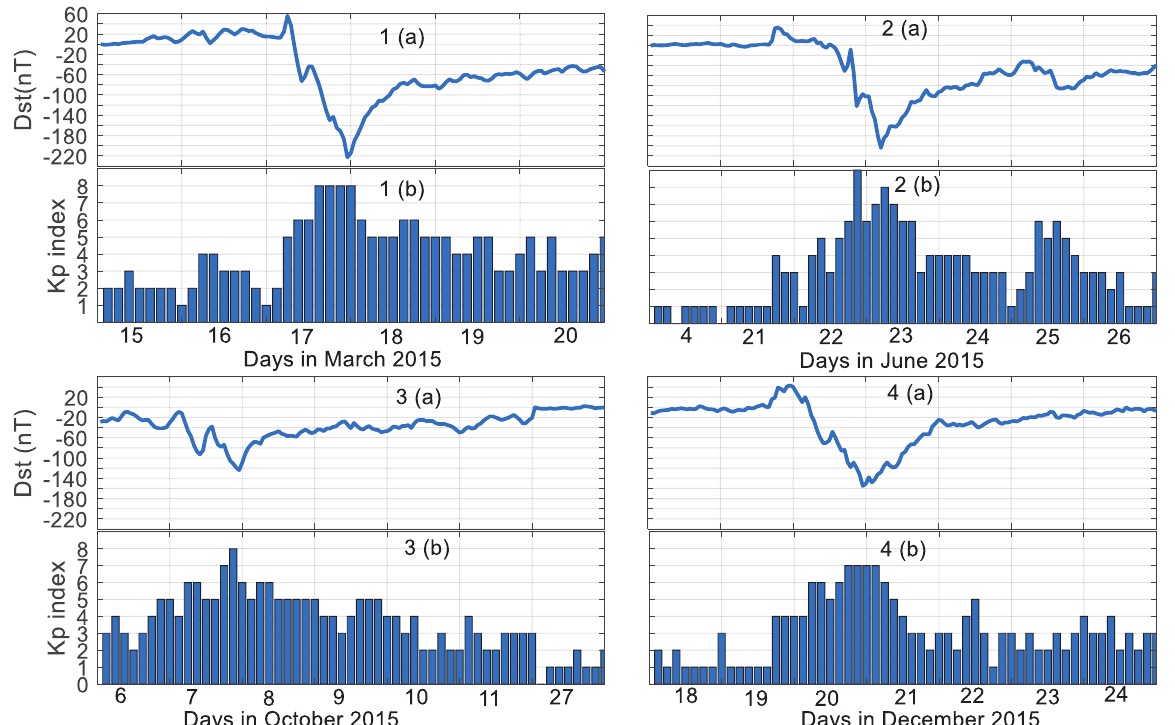
Figure 1. Variation of (a) Dst and (b) Kp during (1) March 15 – 20, 2015, (2) June 4, 21 – 26, 2015, (3) October 6 – 11, 27, 2015, and (4) December 18 – 24, 2015.